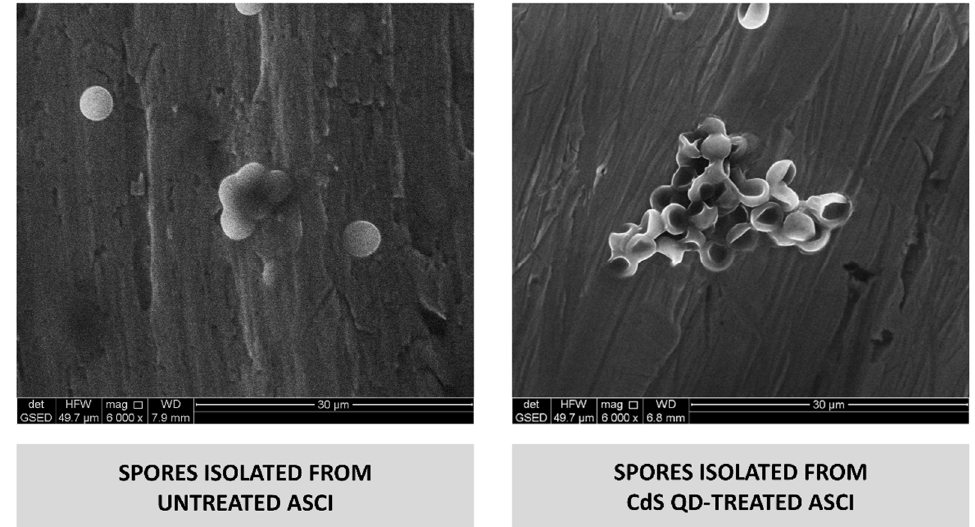
Figure 6. Morphology of spores isolated from untreated and CdS QD-treated (1 mg L − 1 ) asci. Samples were maintained in water prior to observation on machined commercially pure titanium at 6000 × magnification, using environmental scanning-electron microscopy (ESEM) in wet mode.